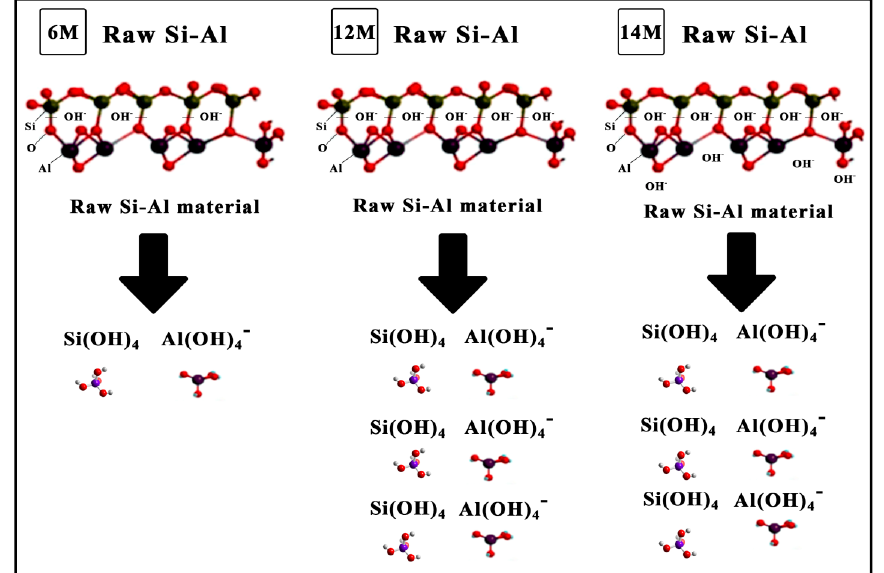
Figure 4. Schematic diagram for the dissolution of Si–Al during geopolymerization.